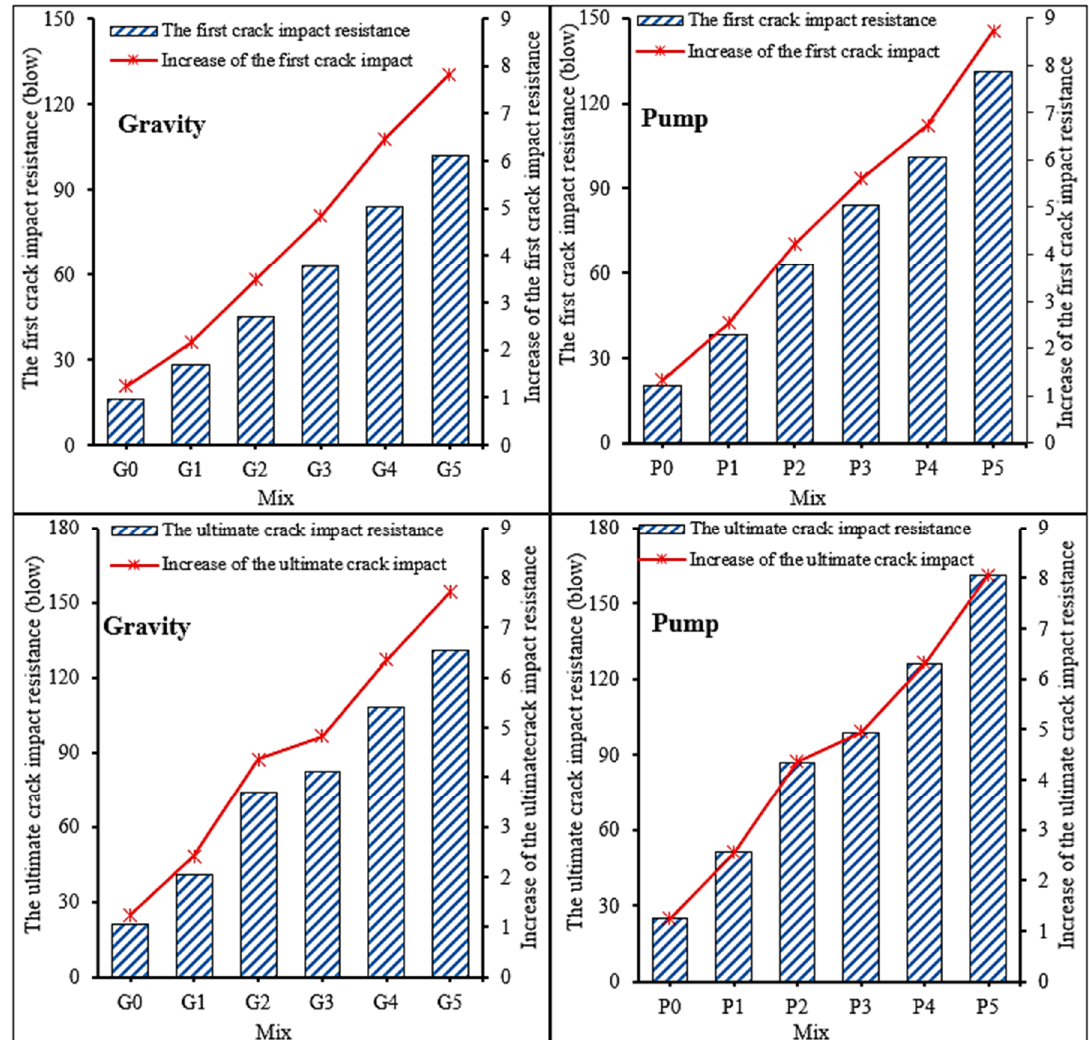
Figure 7. Impact resistance of PAFRC specimens for gravity and pumping techniques.